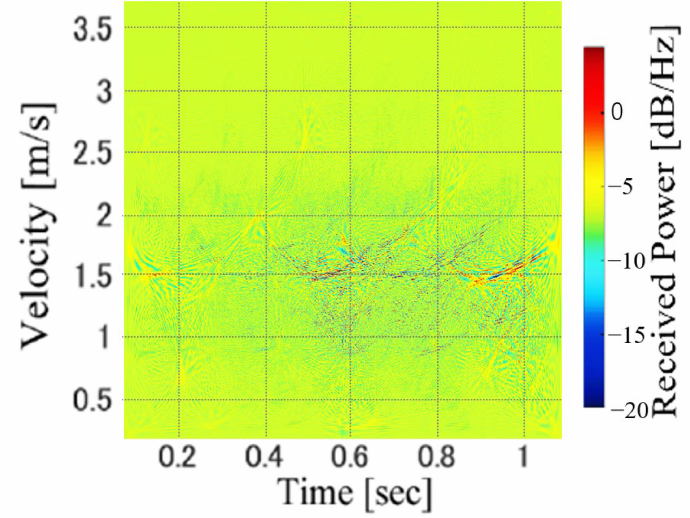
Figure 5. An example of WVD